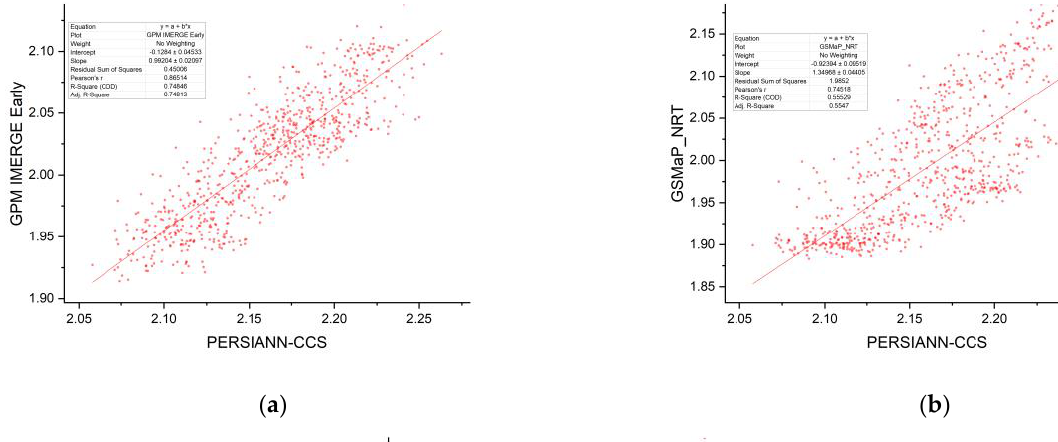
( c ) Figure 13. Spatial distributions of information entropies of three sets of interpolated satellite-based daily precipitation deviation data. ( a ) GPM IMERGE Early; ( b ) GSMaP_NRT; ( c ) PERSIANN − CCS. The correlation among the information entropies of the three sets of satellite precipi- tation deviation data affects the calculation of the joint information entropy and the rank- ing of the stations. The information entropies of the three sets of satellite precipitation deviation data were thus compared grid by grid, and a scatter plot of the information entropy in pairs was plotted, which was then linearly fitted to evaluate the correlations among the three sets of information entropies. Figure 14a shows that the entropies of PER- SIANN − CCS and GPM IMERGE Early exhibit good agreement, followed by that which is between the entropies of PERSIANN − CCS and GSMap_NRT, as shown in Figure 14b. Fig- ure 13 also reveals that PERSIANN − CCS and GPM IMERGE Early are closely correlated according to the spatial distributions of their large and small information entropy values. In contrast, GSMap_NRT shows greater differences between its large and small values, where the large information entropy values are found in the eastern and southern parts of the Oujiang River Basin. Compared with PERSIANN − CCS and GPM IMERGE Early, GSMap_NRT exhibits smaller differences in precipitation deviation in the western part, indicating that GSMap_NRT is more capable of capturing the precipitation in the western part than PERSIANN − CCS and GPM IMERGE Early. The scattered dots enclosed within the line in Figure 14c correspond to those locations in the western part, where the infor- mation entropy of the precipitation deviation of GPM IMERGE Early is significantly larger than that of GSMap_NRT. In general, the three sets of satellite-based data show differ- ences in their abilities to capture precipitation in the area to a certain extent. Although the